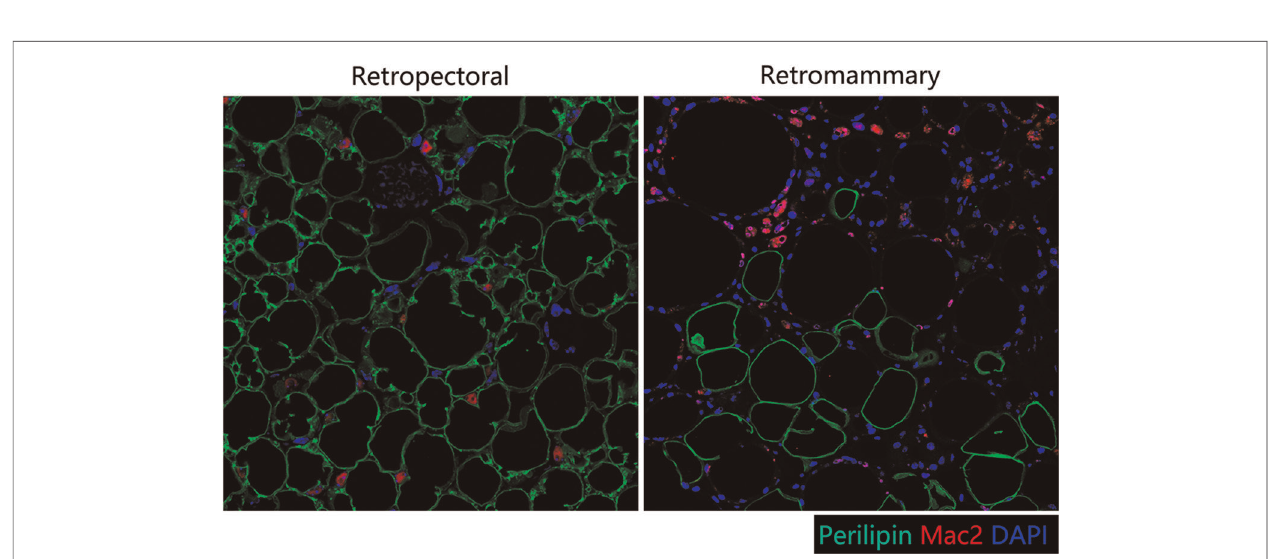
FIGURE 7 | Immuno fl uorescence staining of perilipin and MAC-2. (Left) In the retropectoral transferred fat sample, several multilocular adipocytes and few MAC-2 positive (+) macrophages were found. (Right) In the retromammary transferred fat sample, less adipocytes and more MAC-2+ macrophages were